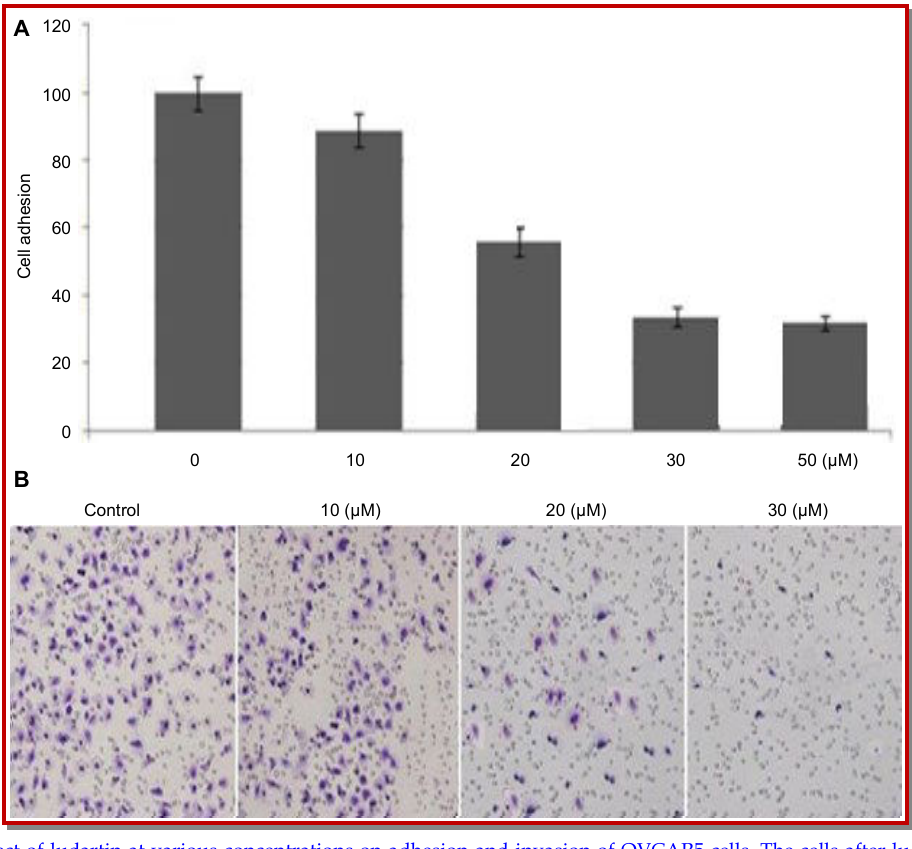
Figure 2: Effect of ludartin at various concentrations on adhesion and invasion of OVCAR5 cells. The cells after ludartin treat- ment were analyzed for cell adhesion and invasion. b p<0.05 compared with the control cells